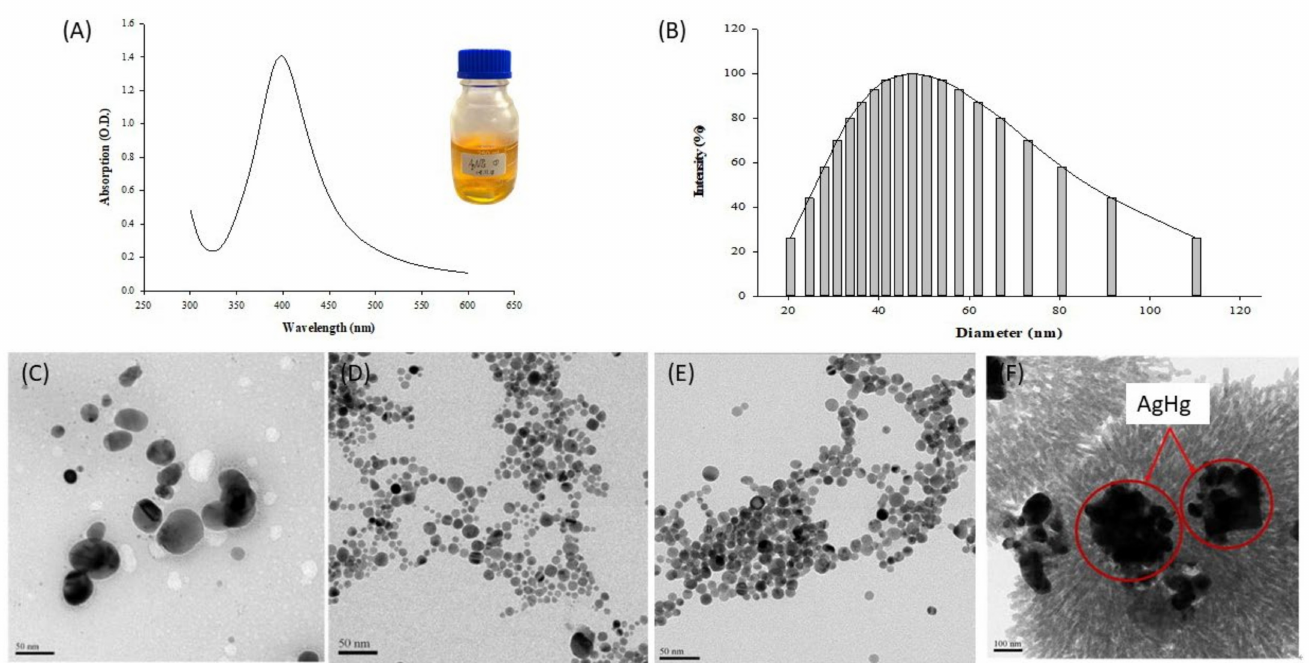
Figure 1. Generation of AgNPs: ( A ) UV–Vis absorption spectrum of silver nanoparticles (AgNPs) with λ = 300–600 nm, the central peak is concentrated at 350–450 nm. The silver nanoparticle colloid color can be seen to be bright yellow; ( B ) Nanoparticle Size Analyzer (NSA) size analysis of silver nanoparticles (AgNPs). The AgNP particle size was measured mainly at 47 nm; ( C ) TEM image of silver nanoparticles (AgNPs) synthesized by silver nitrate, trisodium citrate, and sodium borohydride. TEM image of silver nanoparticles (AgNPs): silver nanoparticles were synthesized when sodium borohydride was added and stirring was stopped immediately ( D ), and after 60 min ( E ); and ( F ) TEM image of Ag amalgam crystals